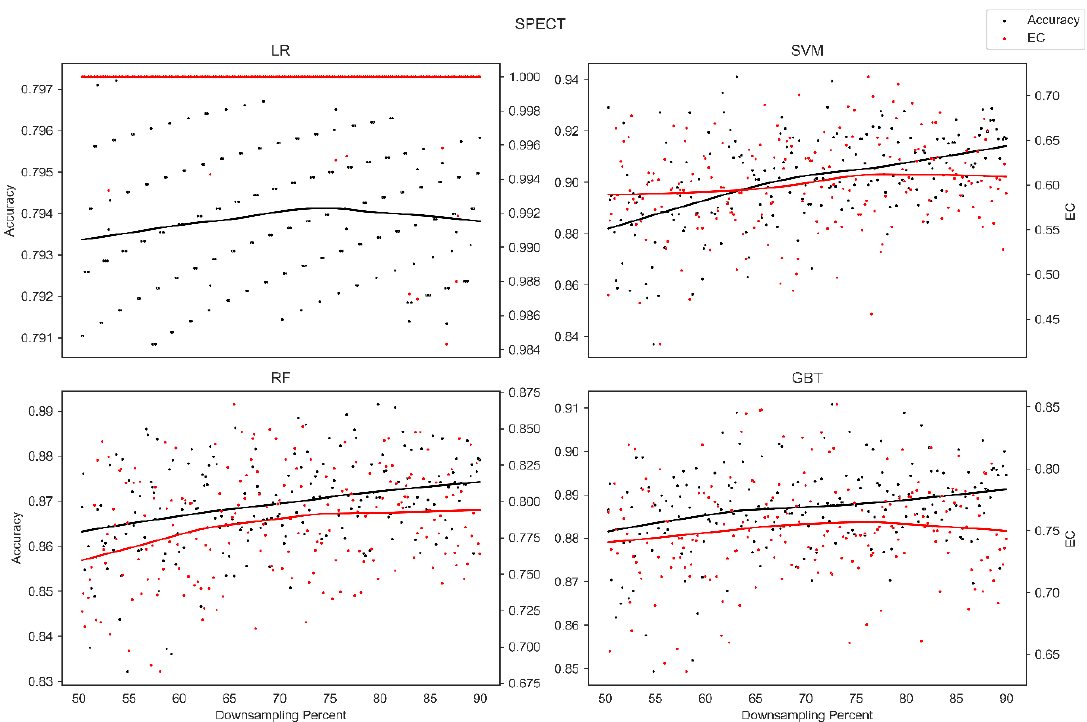
Figure 8. Average error consistency and overall accuracy vs. varying sample size percentages (down-sampled) from the SPECT dataset. Trend lines were established with locally weighted regression and smoothing [25].